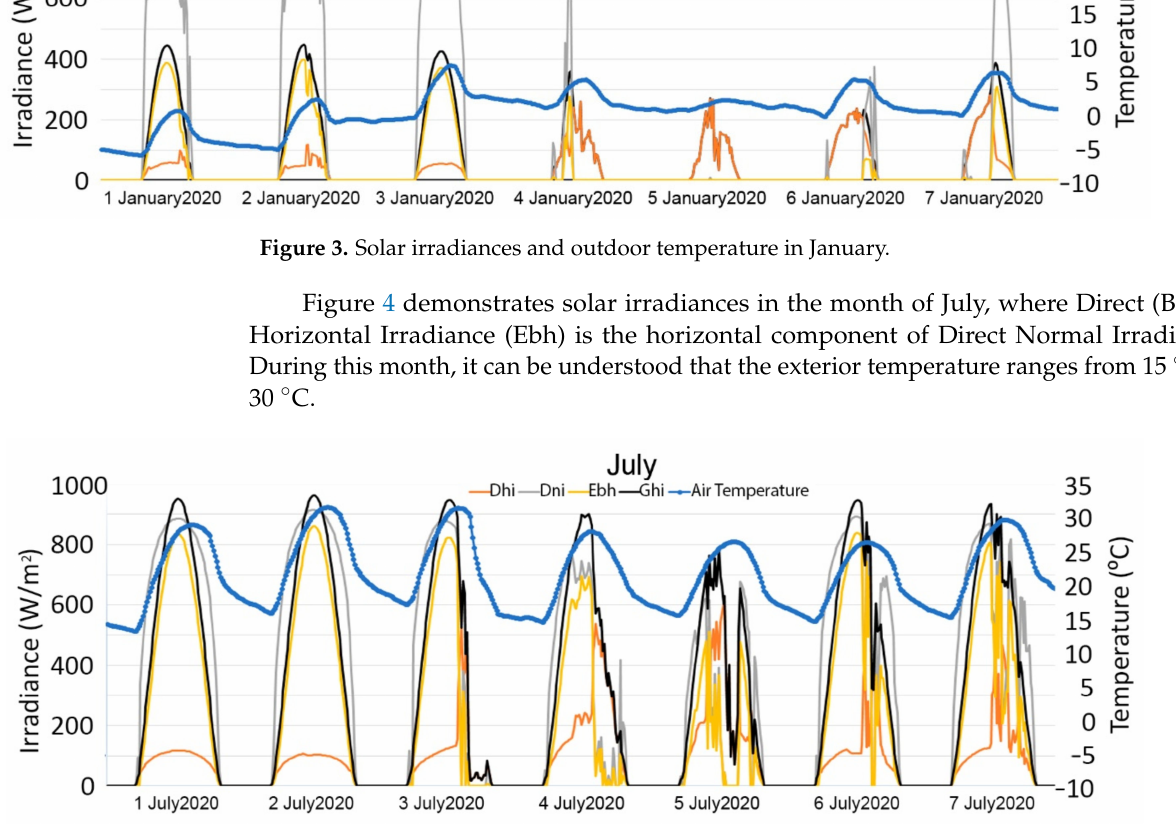
Figure 4. Solar irradiances and outdoor temperature in